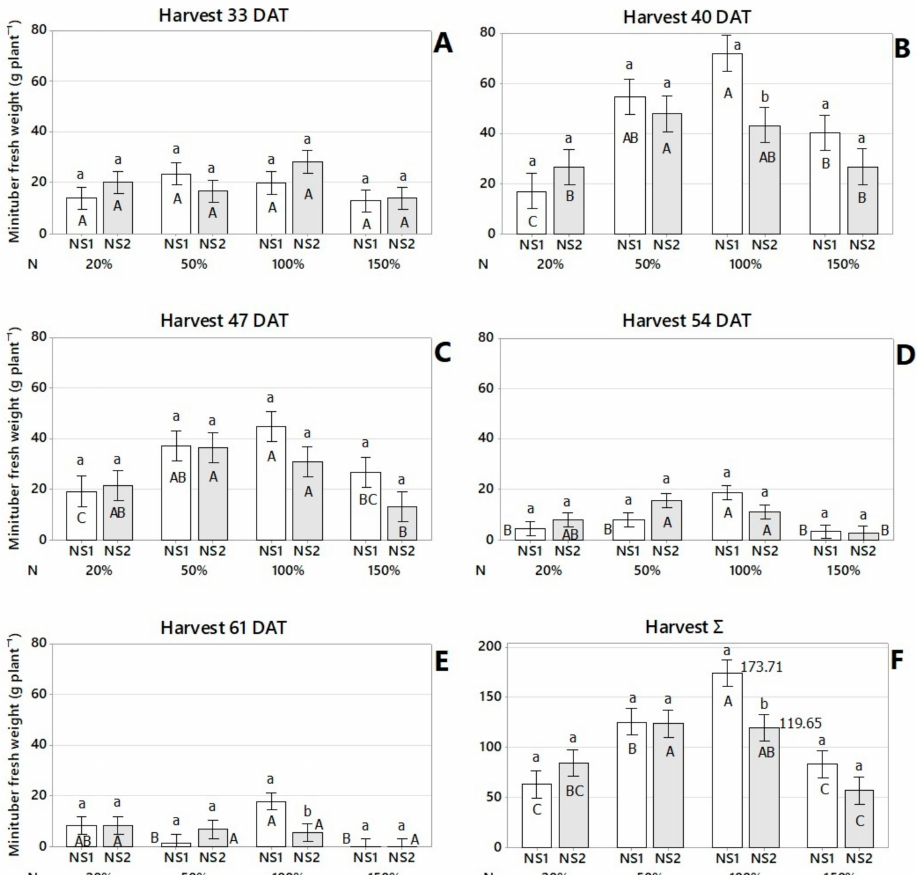
Figure 4. Effect of nutrient solution (NS) and nitrogen (N) concentration on minituber fresh weight at 33 ( A ), 40 ( B ), 47 ( C ), 54 ( D ), 61 days after transplant—DAT ( E ), and total harvest ( F ). Lowercase